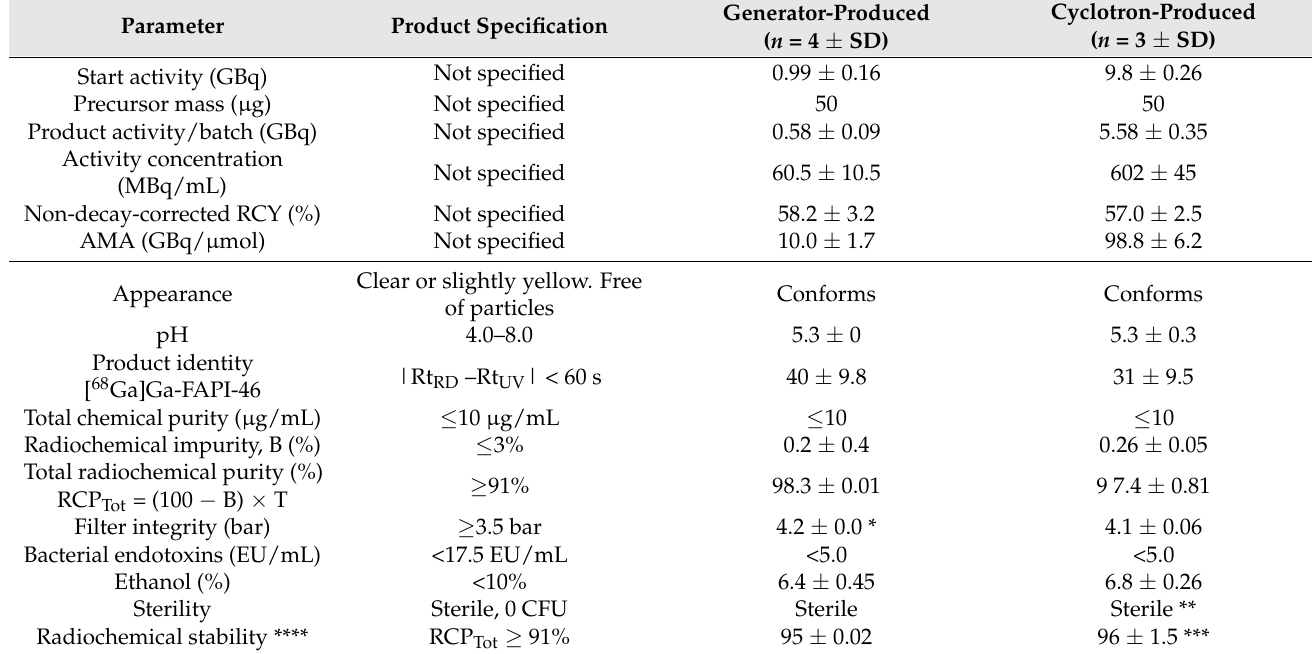
Table 2. Summary of syntheses and QC of [ 68 Ga]Ga-FAPI-46.